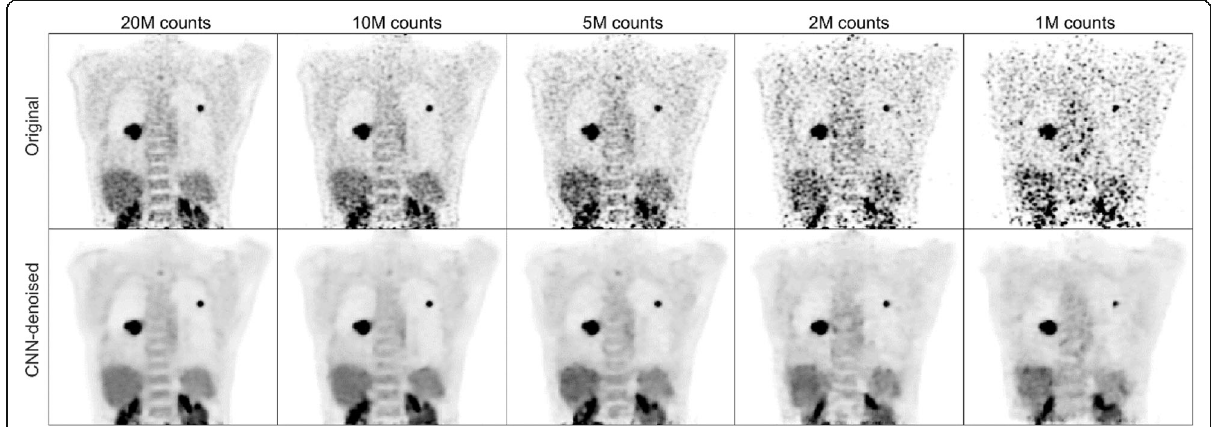
Fig. 2 After training completed, the CNN produced outputs with improved noise properties, relative to the original image volumes — inter-voxel spatial variance was reduced and anatomical boundaries were generally preserved